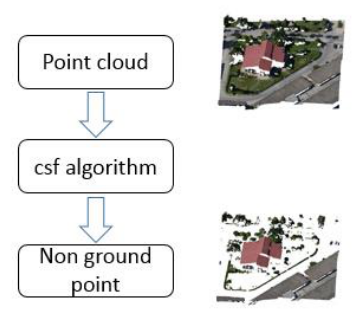
Figure 2. Ground point filtering